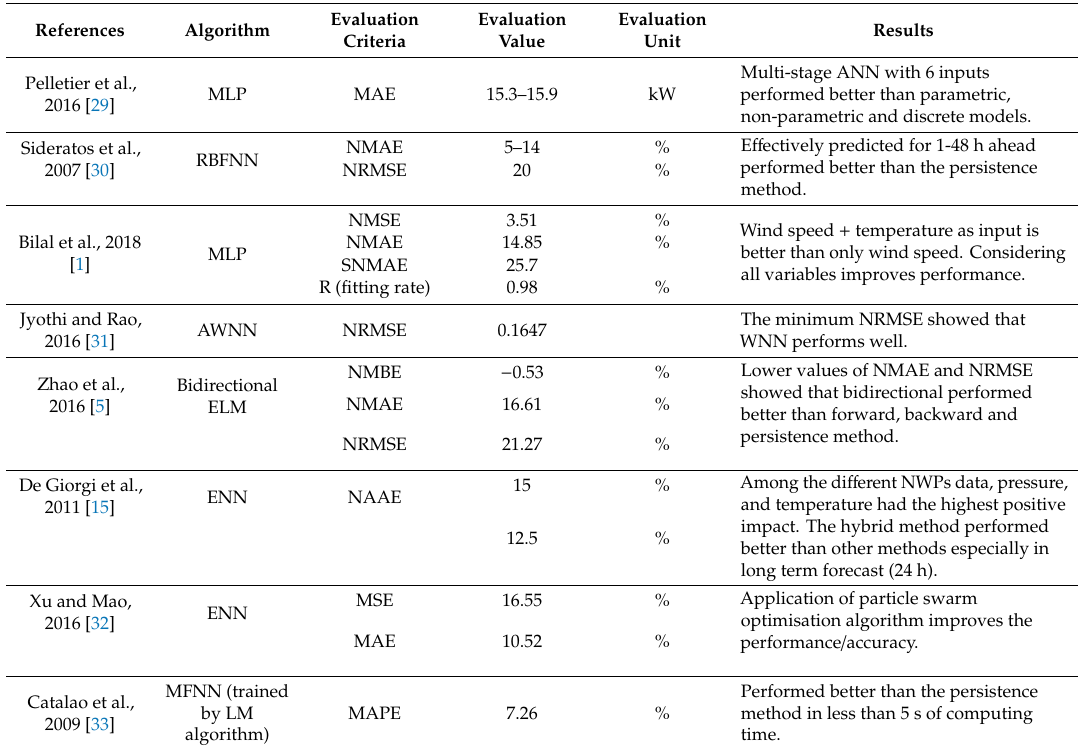
Table 6. Performance evaluation in ANN wind power prediction